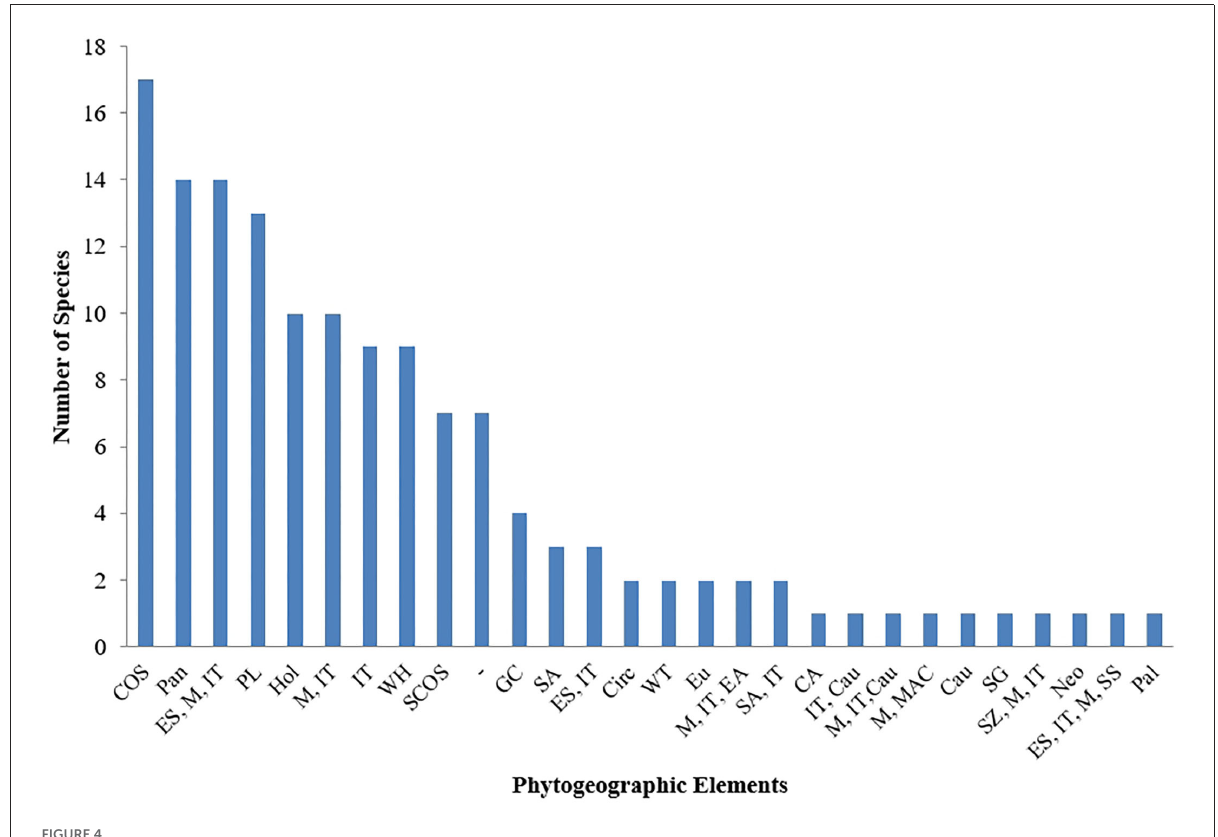
FIGURE4 Floristic elements in Bin Dara, western boundary of